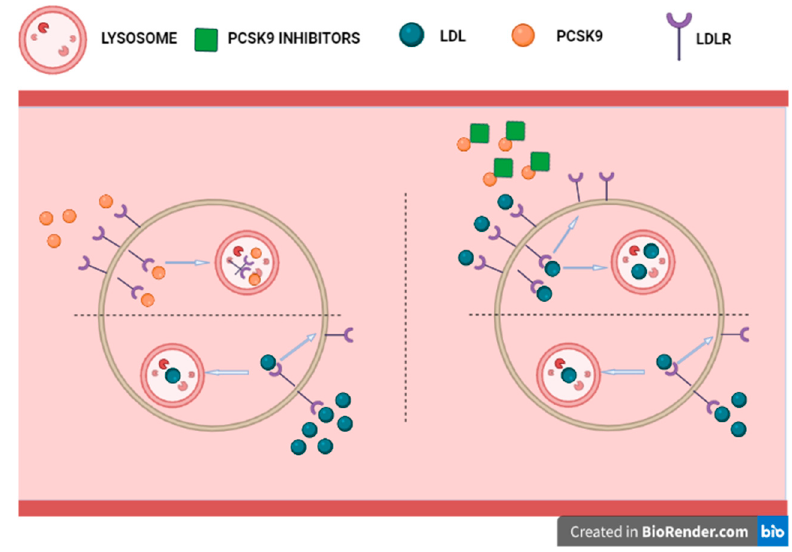
Figure 5. Mechanism for protection of anti-PCSK9.